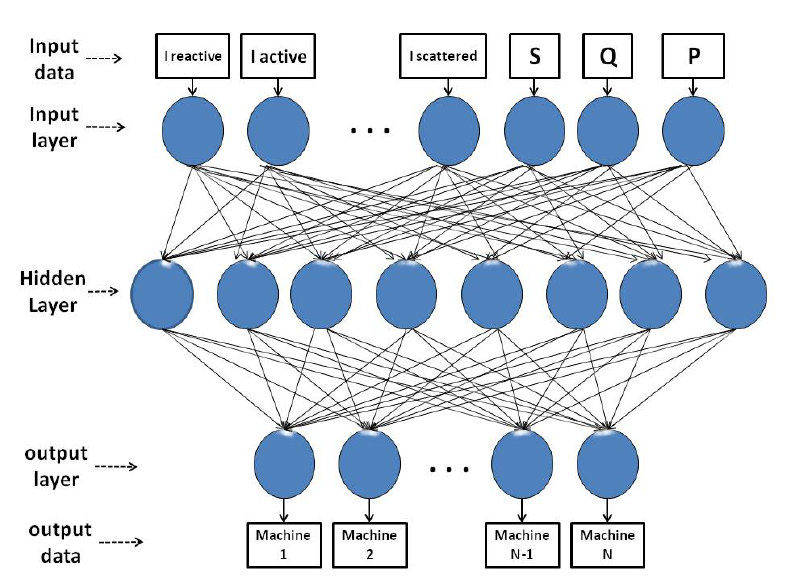
Figure 4. Architecture of the neural